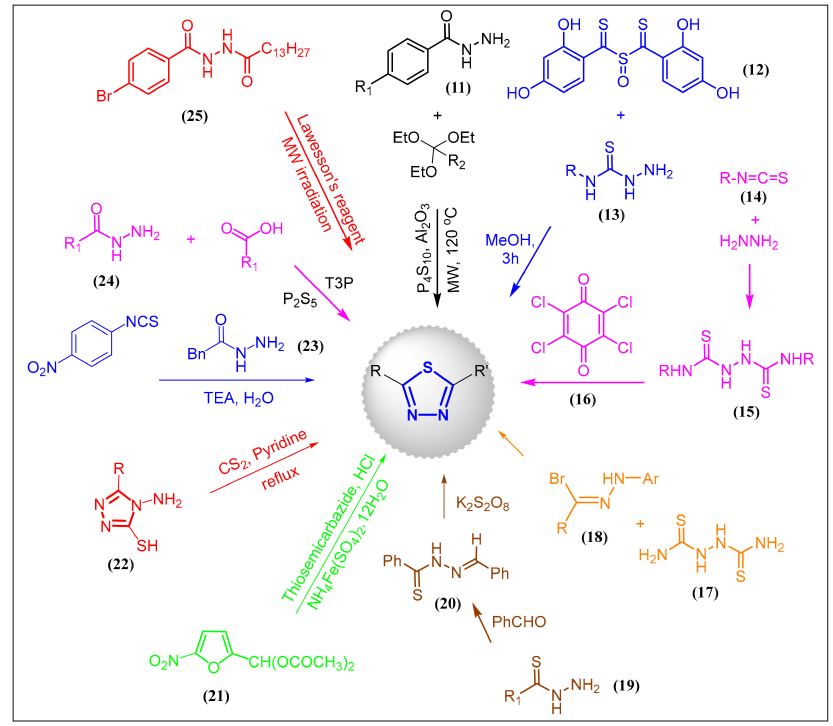
Scheme 1. General preparation of the 1,3,4-thiadiazole nucleus from various routes and